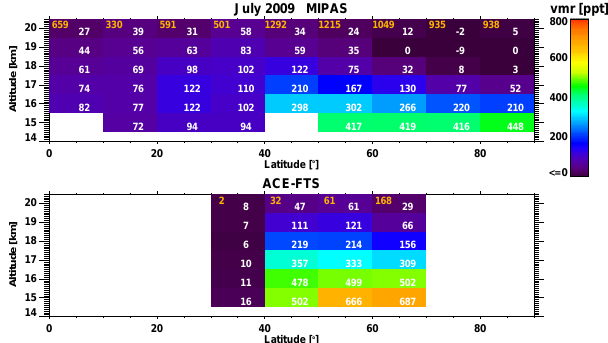
Fig. 10. Latitude–height cross section of MIPAS(top) and ACE- FTS (bottom) zonal mean SO 2 volume mixing ratios in July 2009. Numbers in white show the exact vmr values of each bin in units of ppt. The available number of profiles used to calculate the zonal means are denoted in orange at the top left of each column.